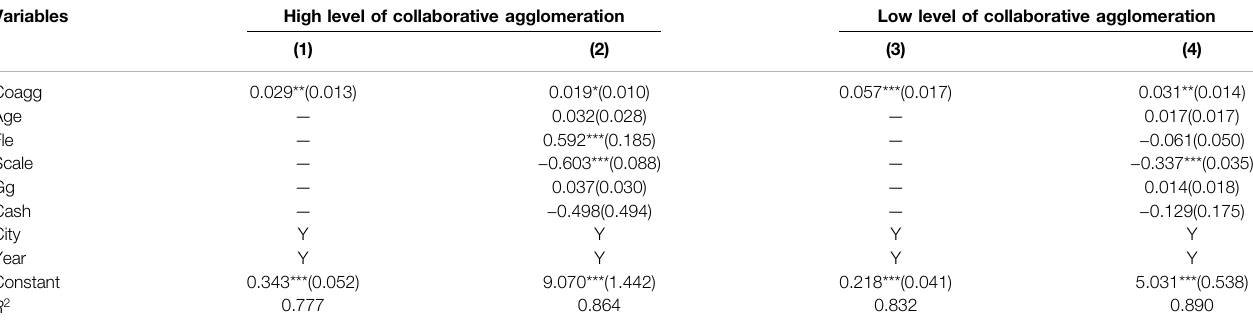
TABLE 3 | High and low levels of collaborative agglomeration.